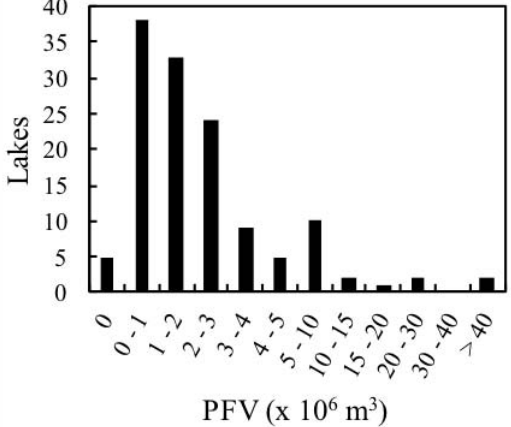
Figure 7. Distribution of potential flood volume (PFV) for all lakes.